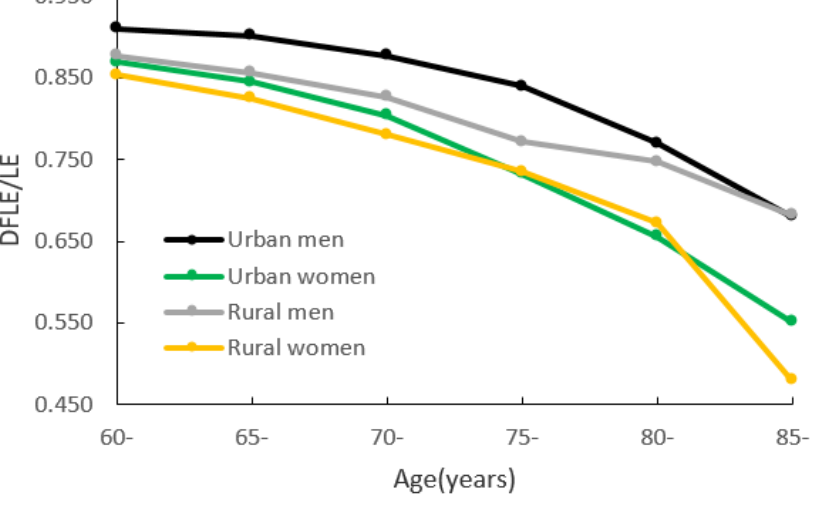
Figure 2. Trends of disability-free life expectancy as a proportion of life expectancy (DFLE/LE) for men and women in urban and rural